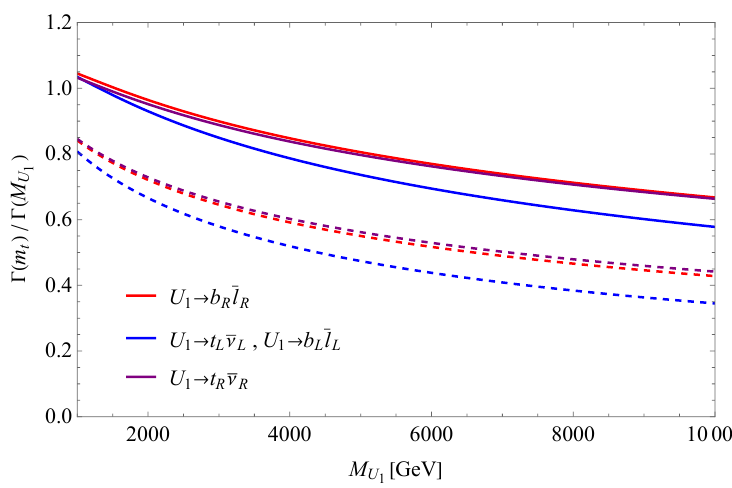
Figure 3 . Resummation effects on the tree-level decay rates for the two-jet decays U 1 → b R ¯ ‘ R (red), U 1 → t L ¯ ν L and U 1 → b L ¯ ‘ L (blue), and U 1 → t R ¯ ν R (purple) as a function of the leptoquark mass M U . The relevant Wilson coefficient are evolved from the scale of the leptoquark mass down 1 to µ = m t . The solid lines show the results of a complete numerical solution of the RG equations, while the dashed curves are obtained by retaining only the cusp terms in the anomalous